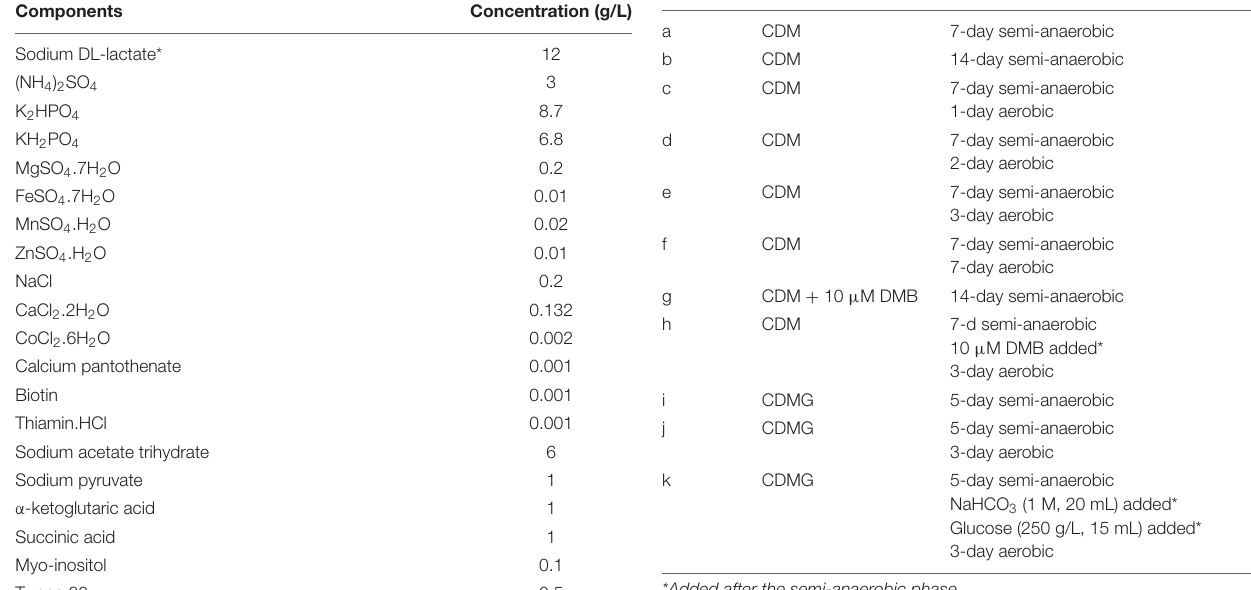
TABLE 1 | Composition of chemically defined medium developed in the current study. Components